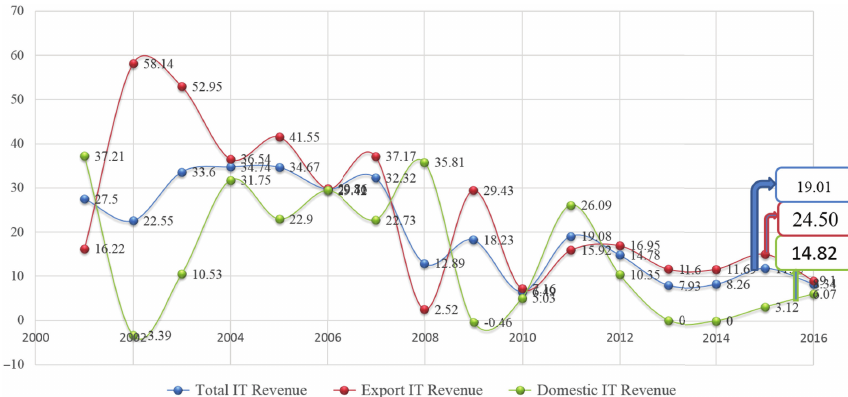
Figure 1. Growth rates of domestic, export and total revenue of the Indian IT